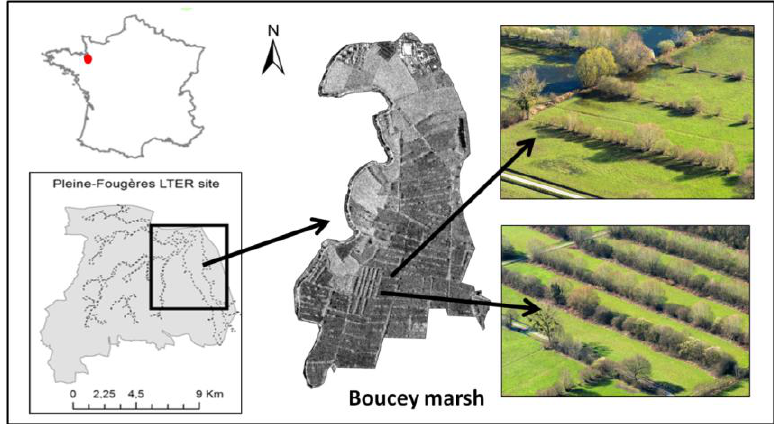
Figure 2. Study site location and examples of two hedgerow